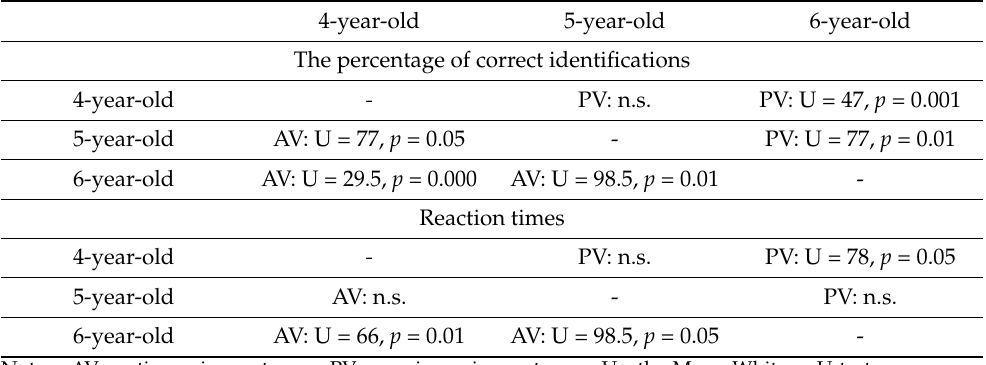
Table 1. Between-group behavioral differences were obtained in the sentence-picture matching